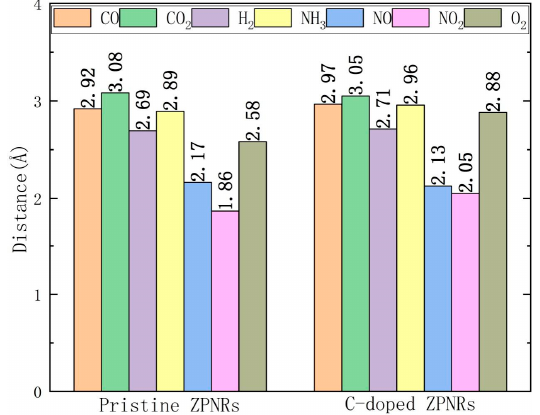
Figure 2. absorption distance of gas molecules on ZPNRs and C-doped ZPNRs. Figure 2. Absorption distance of gas molecules on ZPNRs and C-doped ZPNRs.